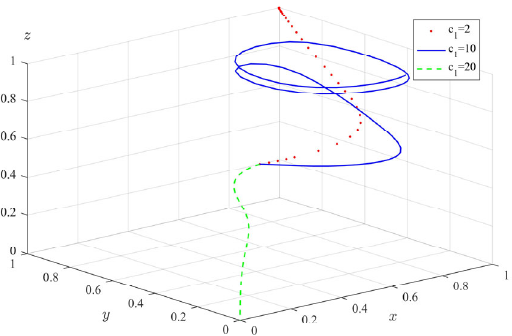
Figure 11. The impact of regulatory fixed costs ( c 1 ) on the evolution of tripartite behavior